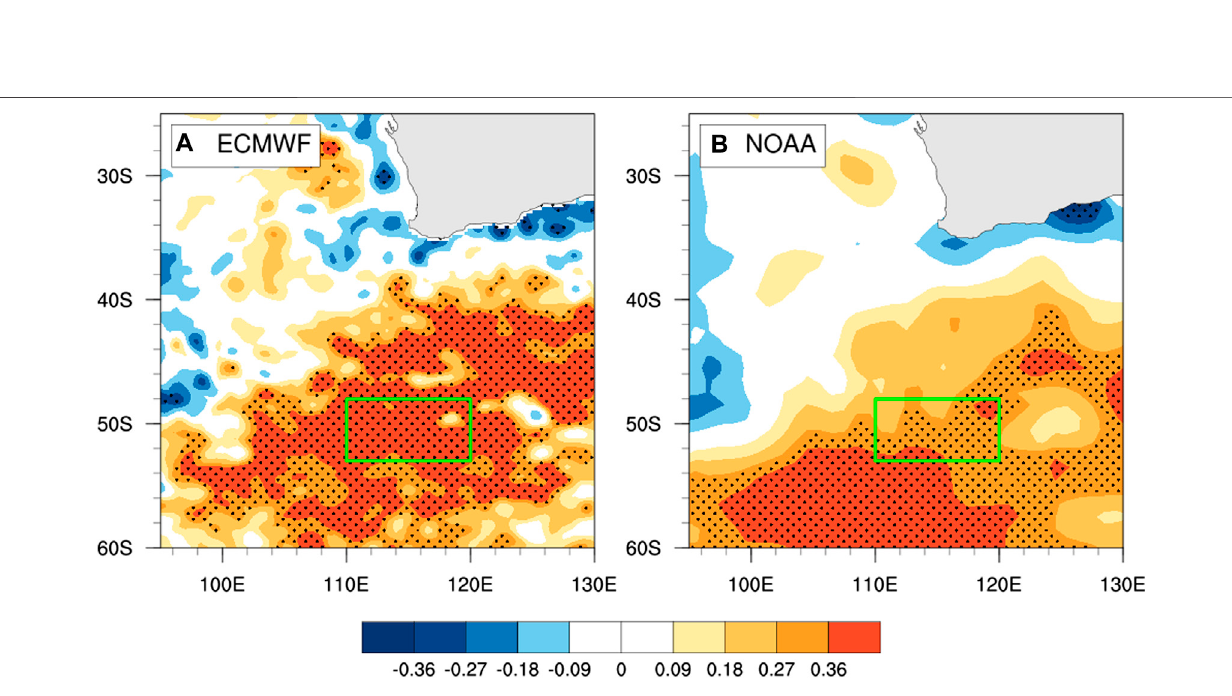
Frontiers in Earth Science |